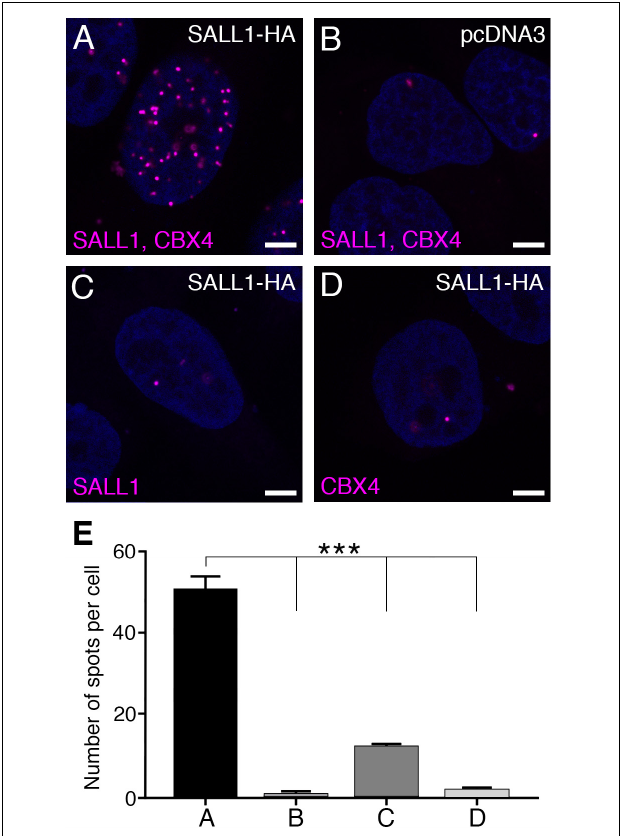
FIGURE 3 | SALL1 and CBX4 interact in the nucleoplasm. (A–D) Confocal pictures of a proximity ligation assay (PLA) showing in situ interaction of SALL1 and CBX4 in the nucleus of U2OS cells, visualized as magenta spots. Cells were transfected with SALL1-HA or with the empty pcDNA3 vector as negative control. Antibodies used in the assay are indicated in magenta. Panel A shows SALL1 and CBX4 interaction, while panels B–D are negative controls. (E) Quantification of PLA signals per cell as in A–D . Bars represent mean plus SEM of three independent experiments. P -values were calculated using one-way ANOVA test. *** P -value <